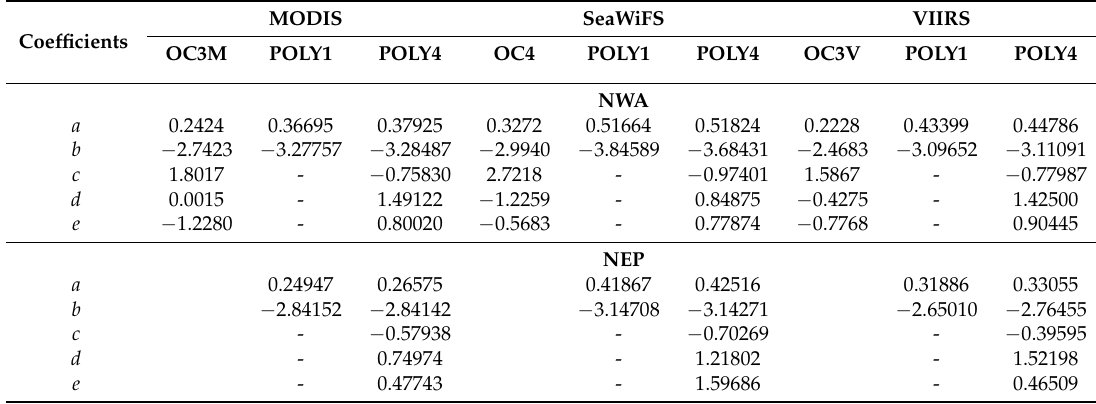
Table 2. Coefficients of the OCx algorithms for each sensor and region.